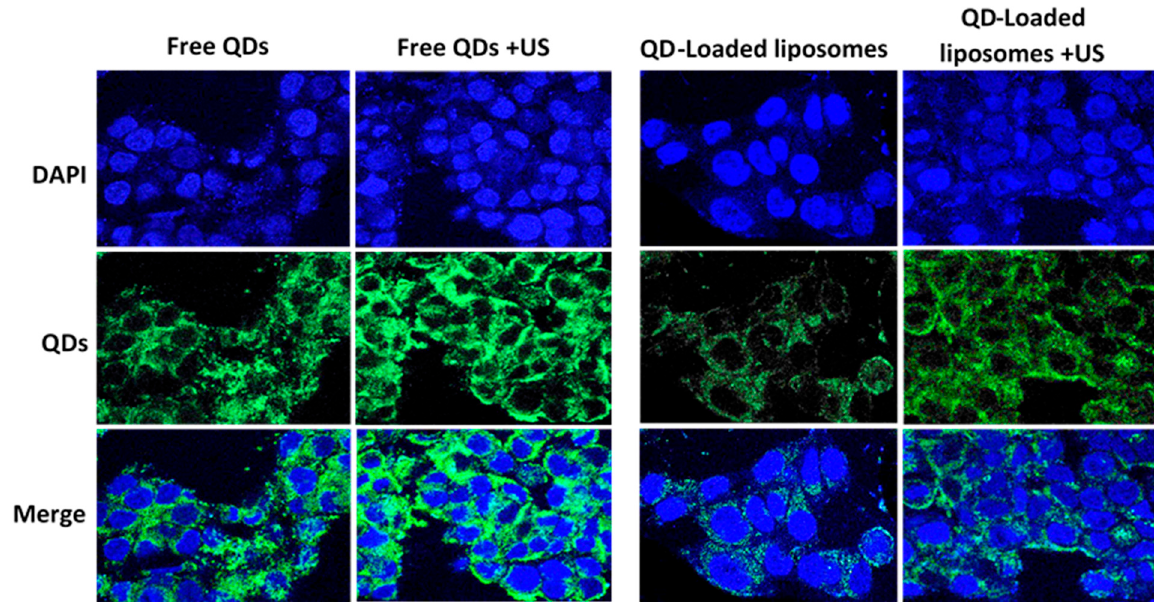
Figure 6. HCT116 cells incubated with free QDs or QD ‐ liposomes with and without sonication with ultrasound (US) for 1 min at 37 °C. The first row only shows the nuclei of the cells stained with DAPI (blue). An argon laser (520/50 nm) was used for QD excitation producing a green fluorescence (second row). The third row shows merged images of both the nuclei and QDs present inside the cells.